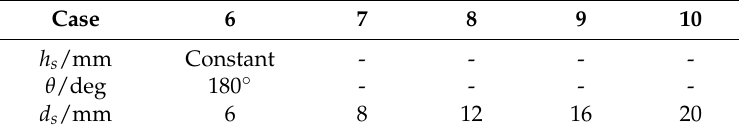
Table 1. Variation in thickness of the selector part.